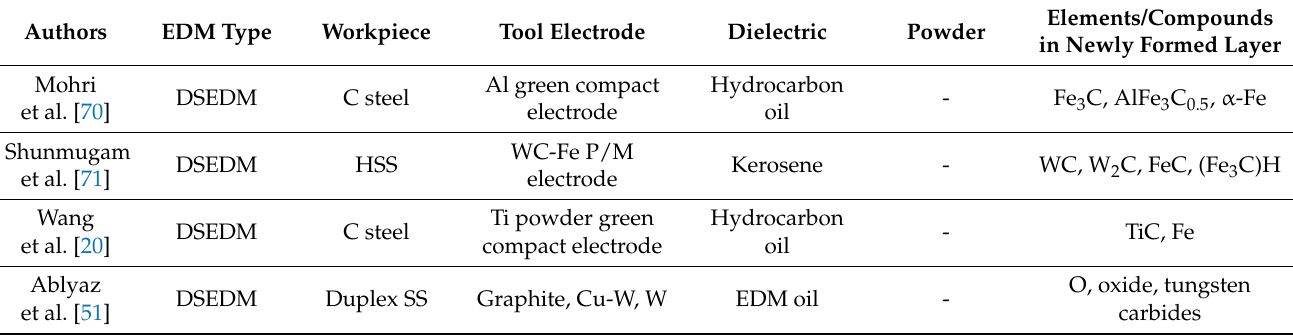
Table 1. Generation of layers over the base material by different EDM